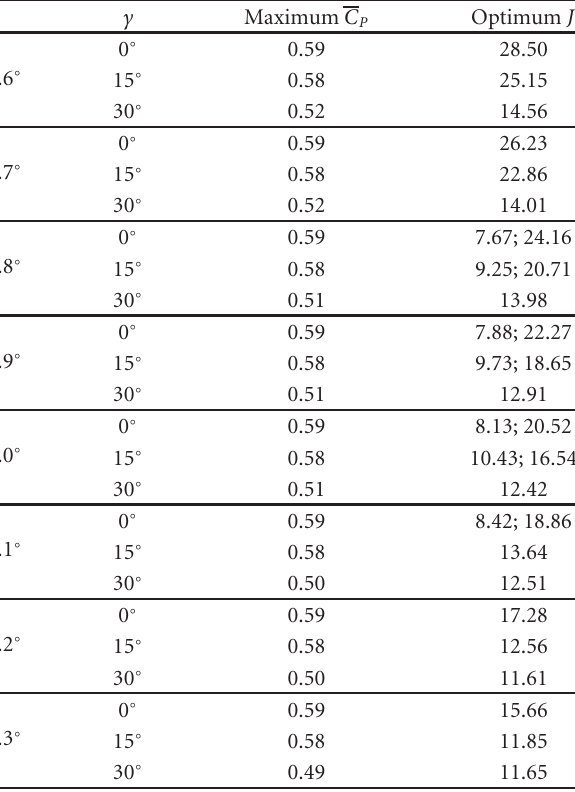
Table 1: Optimum condition at C D =